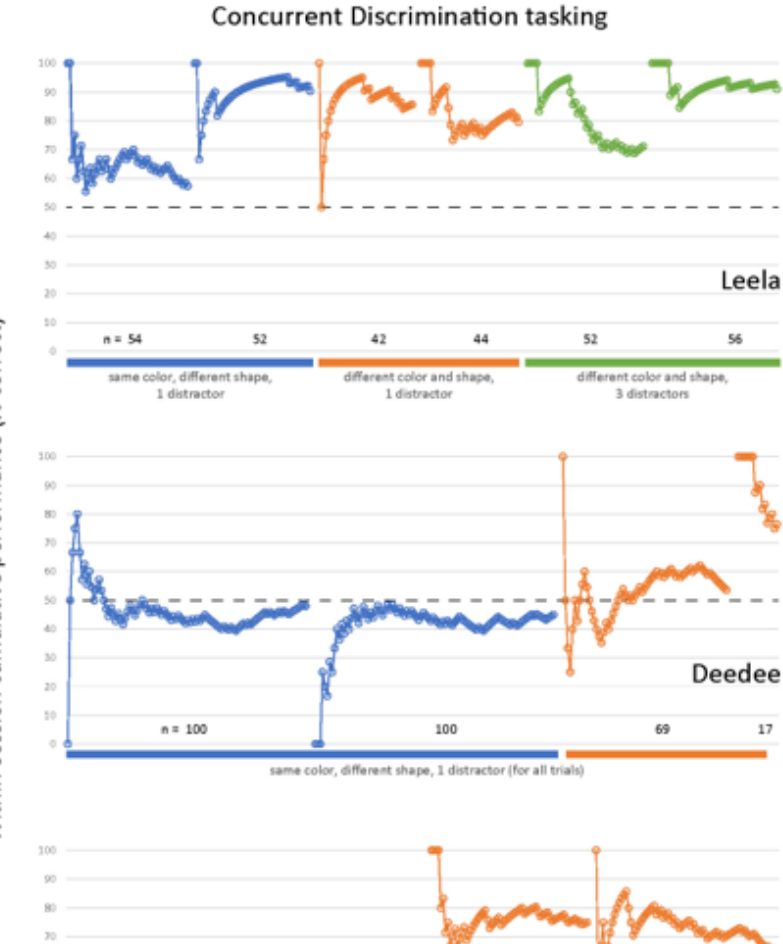
Cumulative Performances for the Concurrent Discrimination (CD) Task, Across